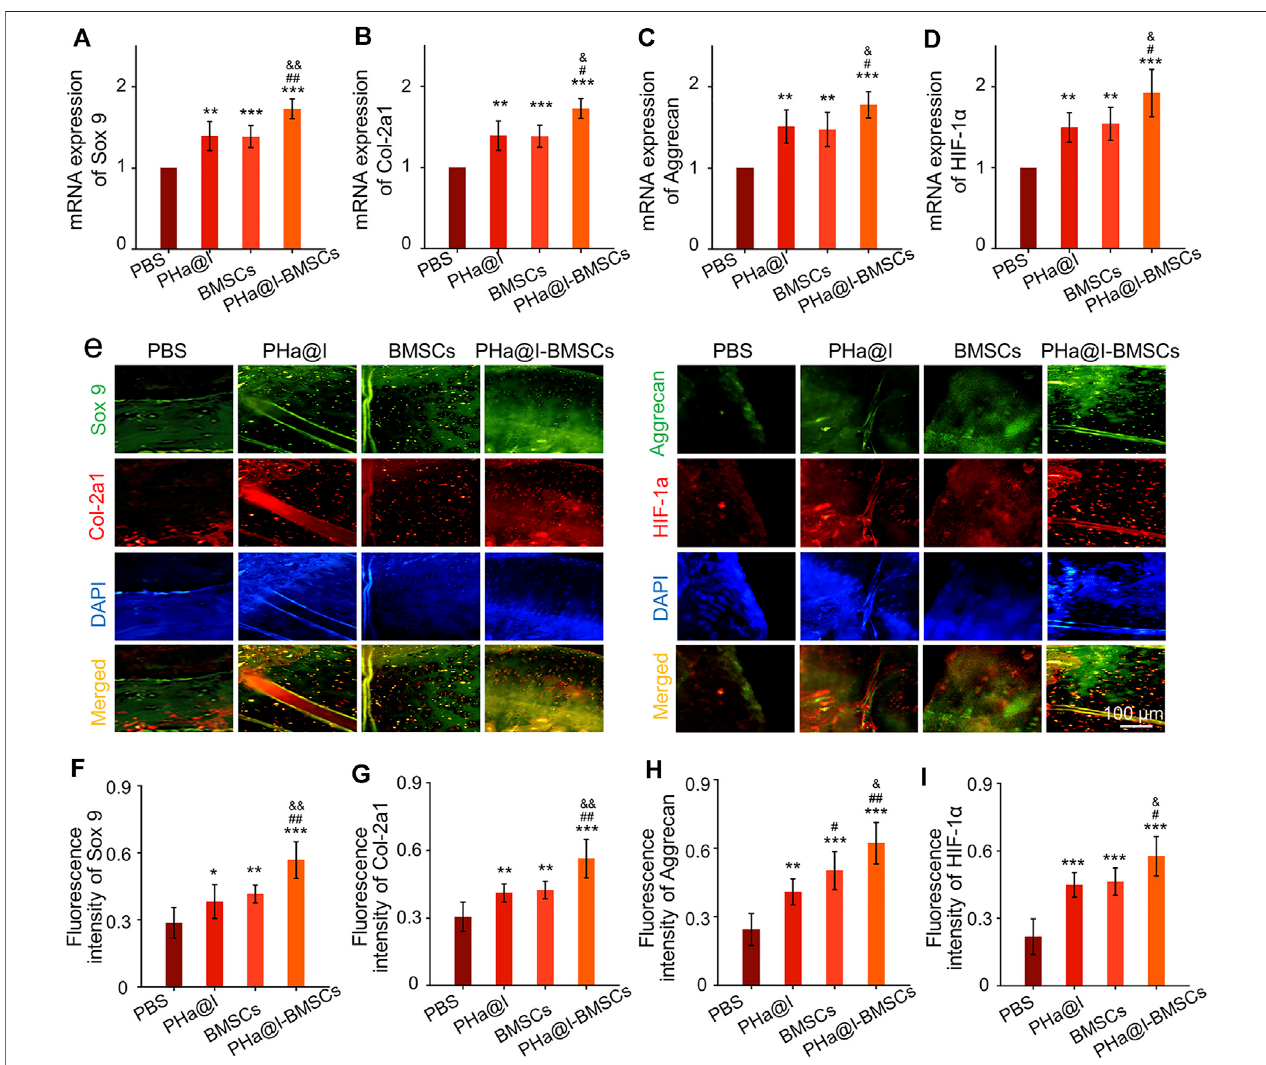
FIGURE 6 | Intra-articular injection of BMSCs incorporating PHa@I hydrogels enhance chondrogenesis. (A – D) RT-qPCR analysis of chondrogenic-related genes Sox9 , Col-2a1 , Aggrecan ,and HIF-1 α incartilageat12 weekspost-injection. (E) Representativedoubleimmuno fl uorescenceimagesofSox9,Col-2a1,Aggrecan,and HIF-1 α in cartilage at 12 weeks post-injection. (F – I) Quantitative analysis of fl uorescence intensity of Sox 9, Col-2a1, Aggrecan, and HIF-1 α in immuno fl uorescence staining (* p < .05, ** p < .01, and *** p < .001 compared with the PBS Group; # p < .05 and ## p < .01 compared with the PHa@I Group; & p < .05 compared with the BMSC Group, n =